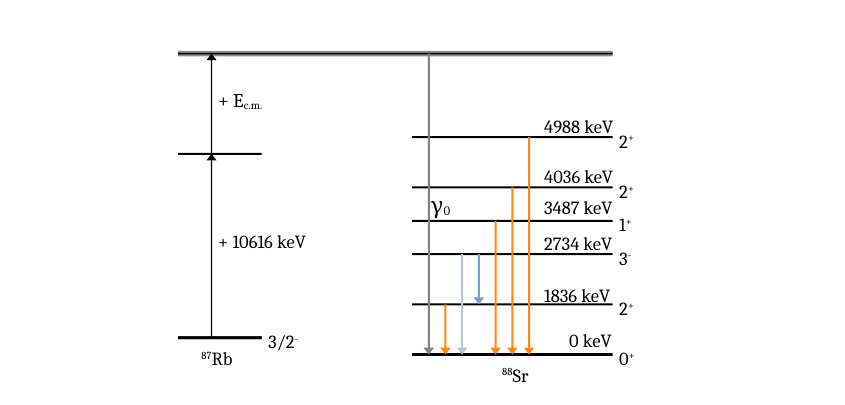
Figure 1. Schematic level scheme of the 87 Rb(p, γ ) reaction [5]. The observed γ -ray transitions to the ground state are shown in orange. The transition in light blue was not investigated directly but indirectly via the branching ratio [5] of the transition in darker blue.